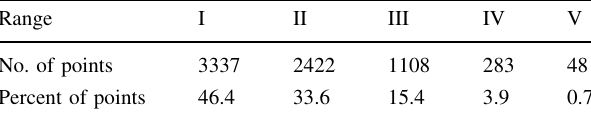
Table 8 Statistics of comparison of the disturbed point cloud with NURBS surface from BF mesh Range